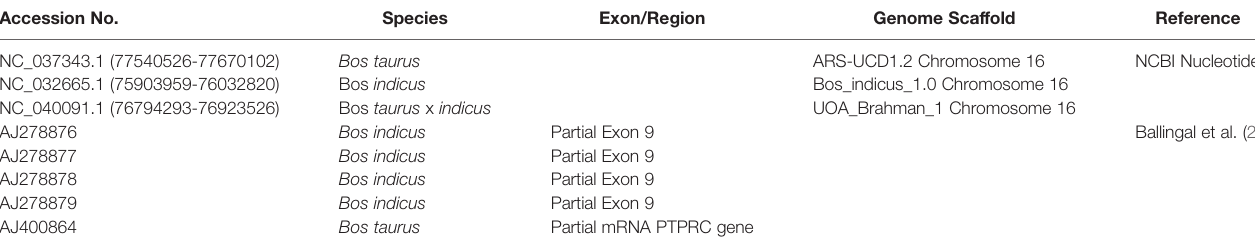
TABLE 2 | Accession numbers and references for nucleotide sequences used in this study. Accession